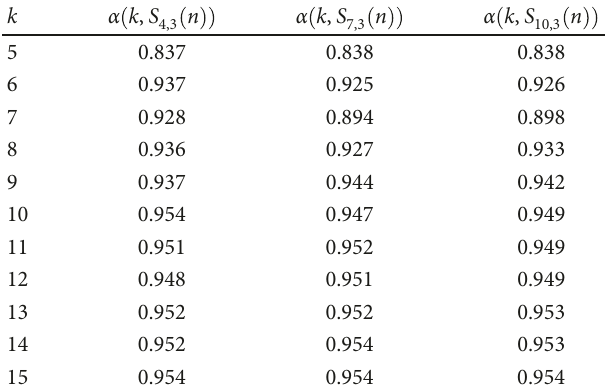
Table 8: Values of α k , S 5 ≤ k ≤ 15 .